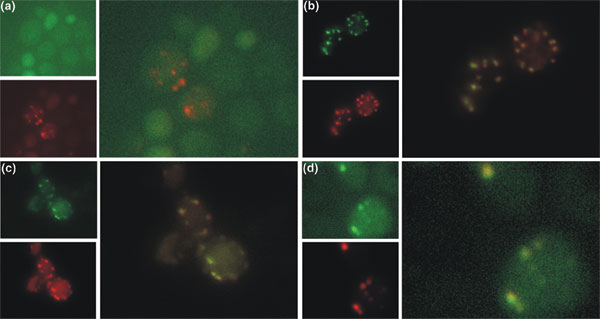
Targeting of GFP-MRP7 and GFP-GSA to peroxisomes in yeast cells. Fluorescence of CB80 yeast cells expressing (a) GFP and DsRed-SKL; (b) GFP-SKL and DsRed-SKL; (c) GFP-MRP7 and DsRed-SKL; or (d) GFP-GSA and DsRed-SKL. Transformed cells were cultured on oleate and observed live for fluorescence. Control experiments (a) show that GFP co-localizes with Ds-Red-SKL only when the sequence -SKL is appended at its extreme carboxyl terminus (b). The figures reveal a punctuate fluorescence pattern for GFP fused to the yeast mitochondrial ribosomal protein L2 encoded by MRP7 (c) or to the bacterial enzyme glutamate-1-semialdehyde 2,1-aminomutase (GSA) (d). Both fusion proteins co-localize with DsRed-SKL in yeast peroxisomes. GFP fused to GSA without its carboxy-terminal -AKL gave rise to a diffuse (cytosolic) fluorescence pattern (data not shown).